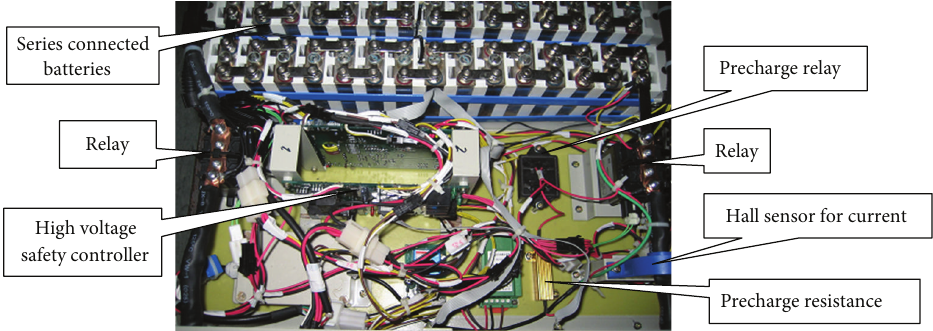
Figure 1: The related components of high voltage safety management system.